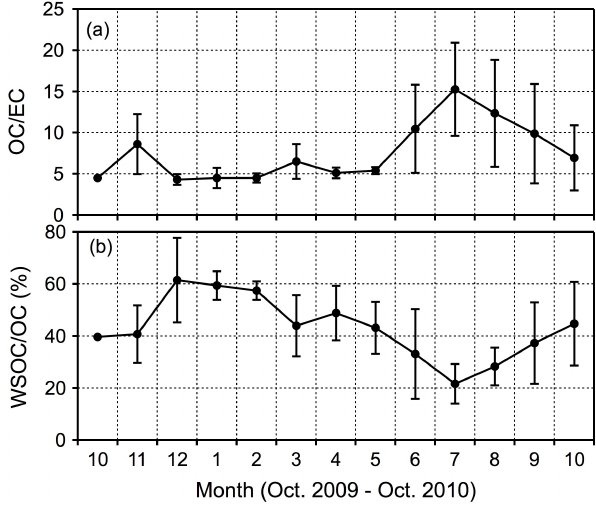
Fig. 7. Monthly average variations of concentration ratios of (a) or- ganic carbon (OC) to elemental carbon (EC), and (b) water soluble organic carbon (WSOC) to organic carbon (OC) in ambient aerosols collected from Cape Hedo Okinawa during October 2009 to Octo- ber